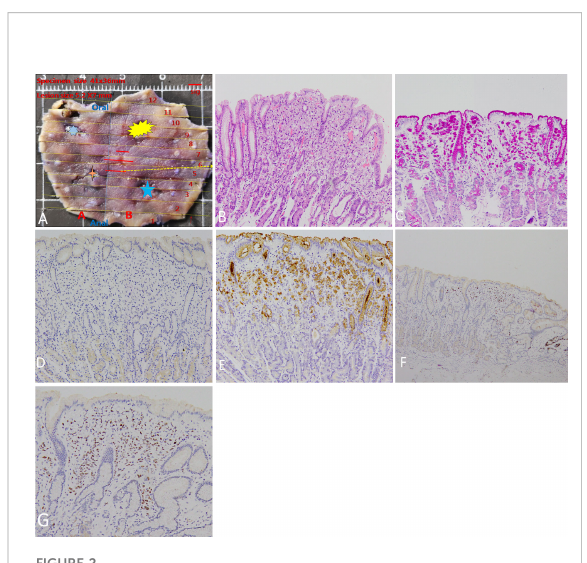
FIGURE 2 Pathohistologic manifestation. (A) The resected specimen. The stars represent the sites of four-quadrant biopsies. The red lines represent lesion areas in each slice. Oral is the oral margin of the specimen. Anal is the anal margin of the specimen. (B) Pathohistology shows pure signet ring cell carcinoma. The basement of the lesion is occupied by dense fundus glands, and signet ring cell carcinoma cells grow into the lumen to form an elevated lesion. (C) Positive PAS staining. (D) Negative MUC-2 staining. (E) Diffusely positive MUC-5AC staining. (F) Positive Ki- 67 staining of 30%. The intense ki67 stain on a deep gland on the far right of the panel is just the proliferative end of the bottom of the crypt. (G) Positive P53